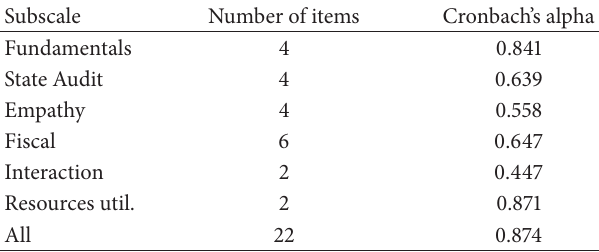
Figure 1: Rasch analysis. Infit and outfit